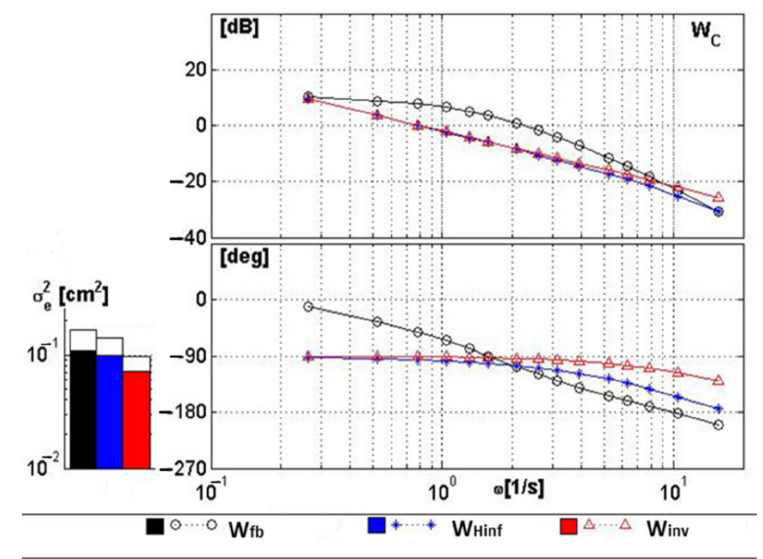
Figure 8. Experimental results.